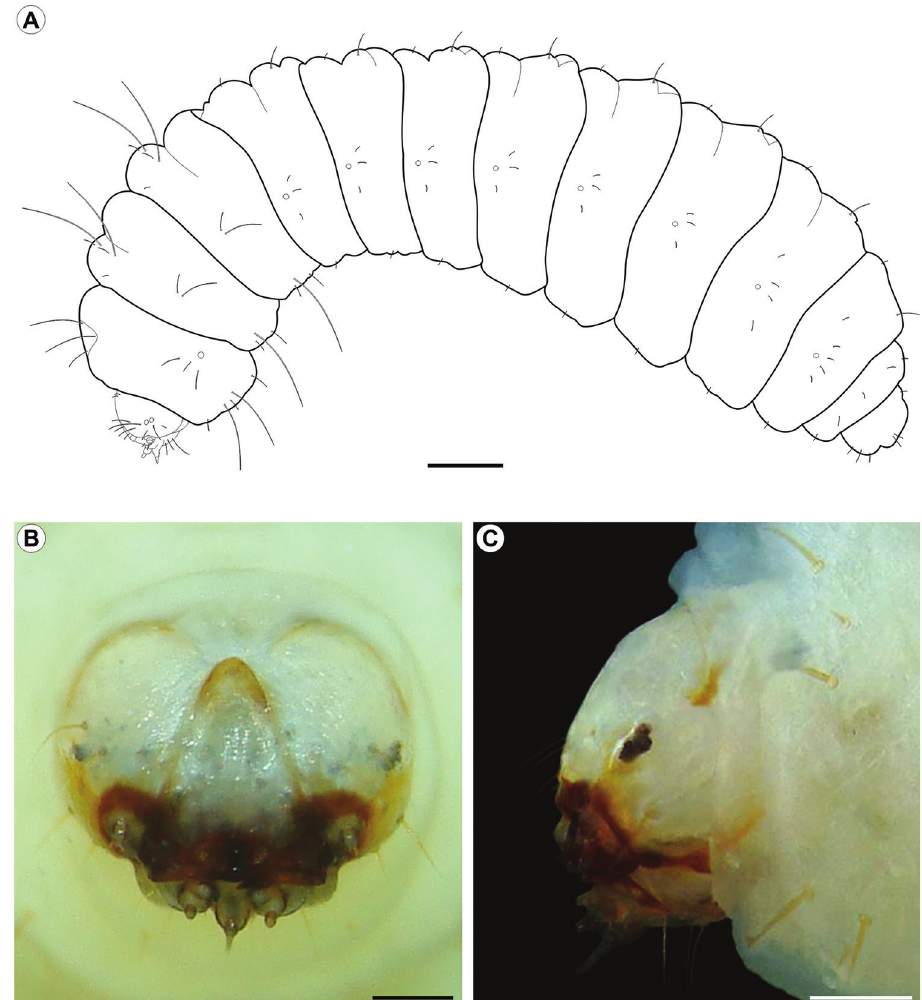
Figure 5. Cecidonius pampeanus last larval instar under light microscopy. A general schematic representa- tion, lateral view B, C head, anterior, and lateral, respectively. Scale bars: 0.5 mm ( A ); 0.2 mm ( B, C ). extended to A4 and A5, respectively; metathoracic legs reaching beyond forewing apex on segment A7 (Fig. 7). Frons and lateral portion of vertex with two pairs of setae each; tergum T2 with a pair of latero-dorsal setae; tergum T3 with a single seta on each side. Abdominal segments with central region covered by microtrichia; A2–9 with a trans- verse band of stout spines (Fig. 8E), near anterior margin of terga; tergum A10 with a pair of acute processes on posterior margin (Fig. 8F). Abdominal setae slightly shorter than thoracic, arranged in three rows (dorsal, supra- and subspiracular); one dorsal pair on segments A1–8; one supra-spiracular pair on segments A2–8; four